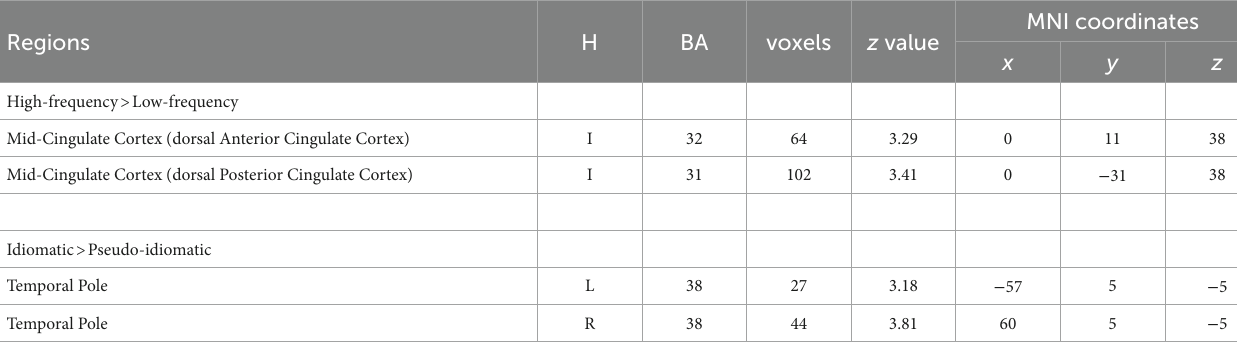
TABLE 2 fMRI results in the whole-brain analyses.